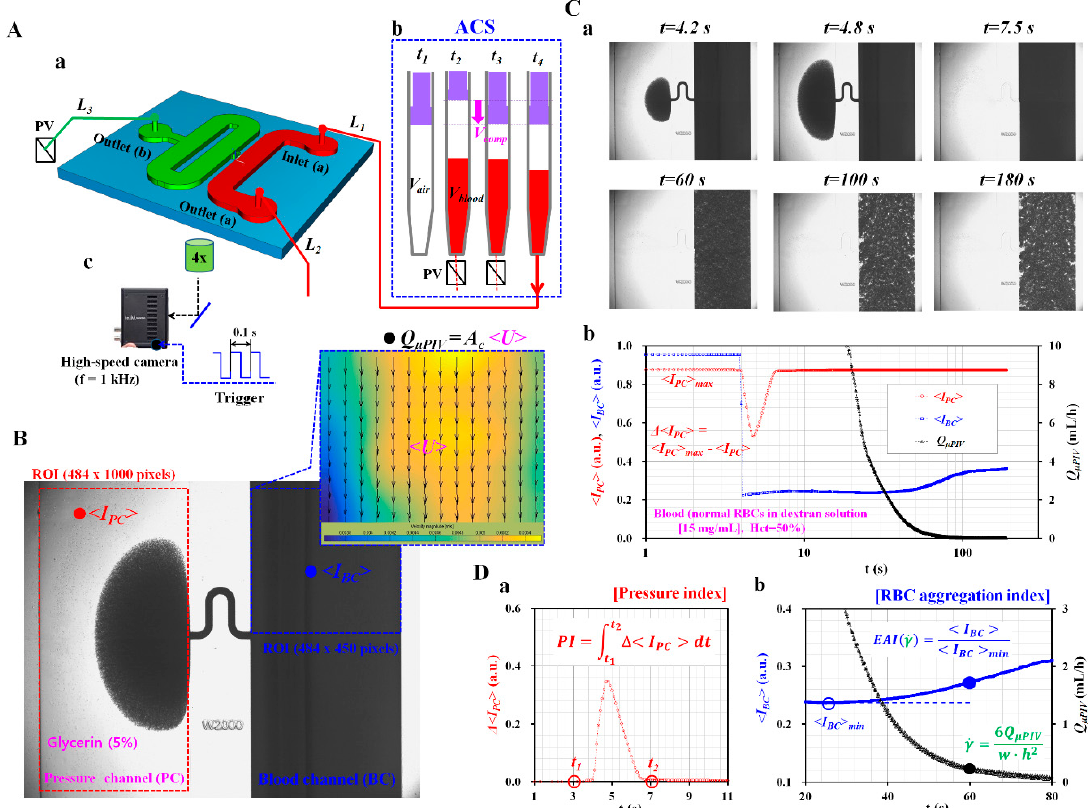
Figure 1. A proposed method for sequential measurement of blood pressure and red blood cells’ (RBCs) aggregation over varying blood flows. ( A ) A schematic diagram of the proposed method, including disposable air-compressed syringe (ACS), a microfluidic device, two pinch valves (PVs), and an image acquisition system. ( a ) A microfluidic device was composed of an inlet (a), two outlets (a,b), and two channels (pressure channel (PC), and blood channel (BC)). ( b ) The ACS was operated in four processes: air suction (V air ) at t = t 1 , blood suction ( V blood ) at t = t 2 , air compression ( V comp ) by clamping outlet tube (L2) with pinch valve at t = t 3 , and blood delivery by removing PV ( t = t 4 ). ( c ) A high-speed camera with a frame rate of 1 kHz was employed to capture two sequential microscopic images at an interval of 0.1 s. ( B ) Two regions of interest (ROI) for evaluating three parameters ( < I PC > , < I BC > , and Q µ PIV ). ( C ) As a preliminary demonstration, the blood sample was supplied into a microfluidic device from the ACS. ( a ) Sequential microscopic images captured at a specific time ( t ) ( t = 4.2 s, 4.8 s, 7.5 s, 60 s, 100 s, and 180 s). ( b ) Temporal variations of three parameters ( < I PC > , < I BC > , and Q µ PIV ) over time. ( D ) Quantification of pressure and RBC aggregation. ( a ) Blood pressure was quantified as pressure index ( PI ) obtained by integrating ∆ < I PC > from t = t 1 to t = t 2 . ( b ) Variations of RBCs aggregation were obtained as erythrocyte aggregation index ( EAI ) over shear rate (i.e., EAI vs. 𝛾(cid:4662) ).